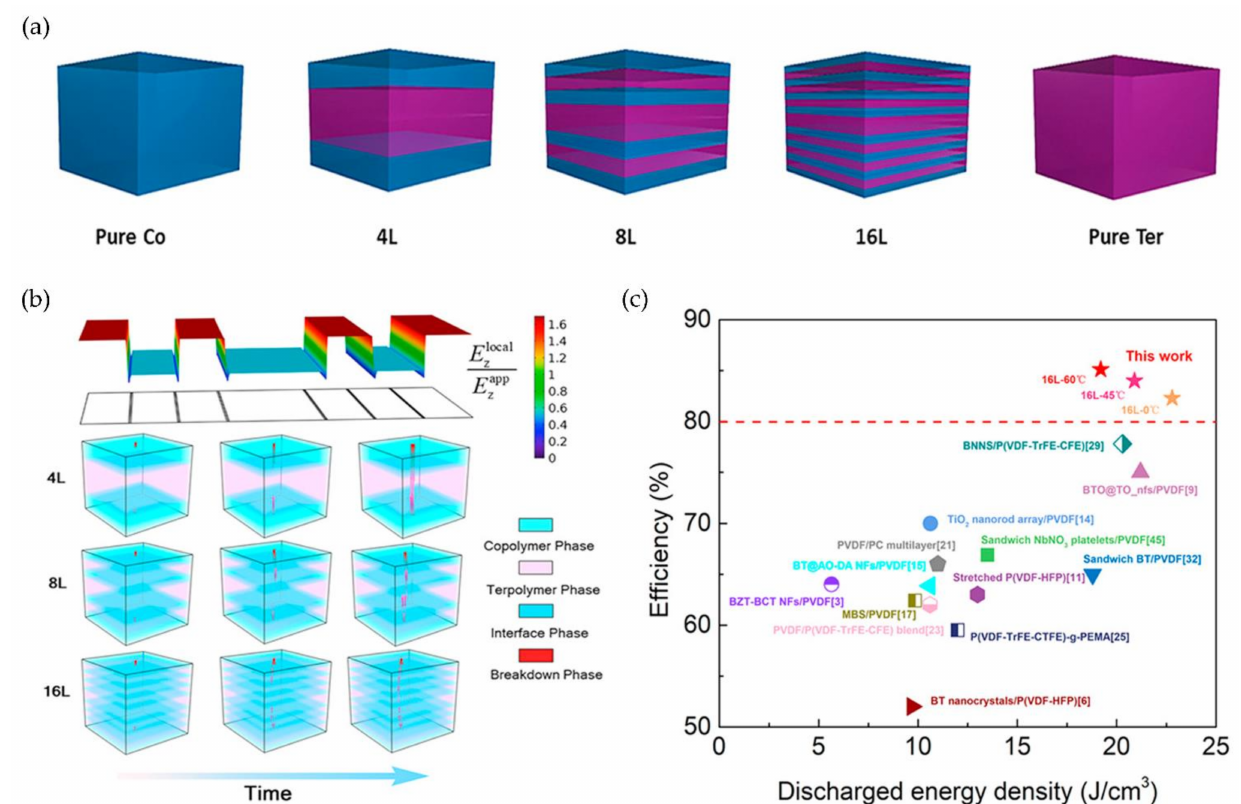
Figure 11. ( a ) Schematic diagram of multilayer structure, pure copolymer and pure terpolymer; ( b ) Comparison chart of discharge energy density and efficiency; ( c ) Schematic diagram of breakdown path evolution with time by phase-field simulation. Reprinted with permission from [117]. Copyright (2018),